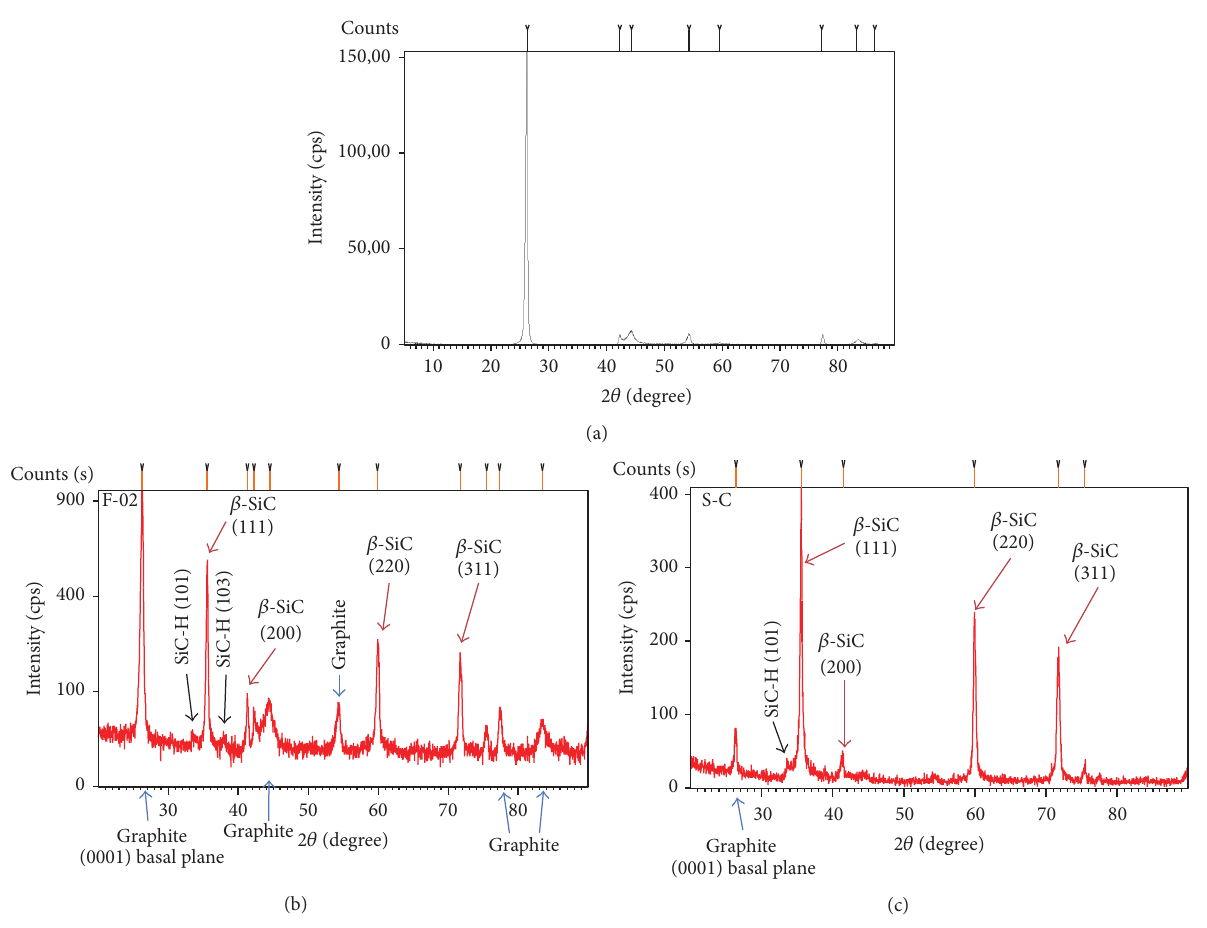
Figure 4: X-ray diffraction patterns of (a) grinded bare graphite, SiC-coated graphite prepared (b) at reaction zone (1) and (c) at reaction zone (2). 𝛽 -SiC: cubic phase; SiC-H: hexagonal